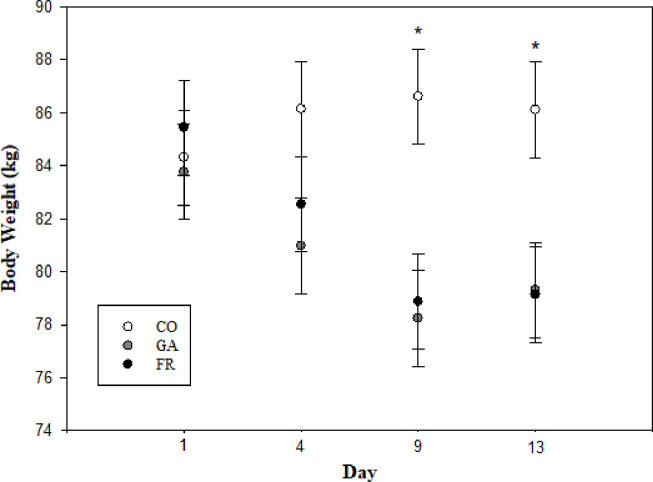
Body weight (BW, kg) during 13 days of treatment of synchronized ewes.Treatments were: (i) Control (CO): fed 1.5 times greater than the dietary maintenance and given a daily subcutaneous (SC) saline infusion (0.1mL/kg BW) (ii) Feed restriction (FR): ewes were fed a diet restricted to 80% of maintenance and given a daily SC saline infusion (0.1mL/kg BW); (iii) Ghrelin antagonist (GA): the same restricted diet as the FR and given a daily SC ghrelin antagonist infusion (7.5μg/Kg BW of [D-Lys3]-GHRP-6 diluted into 0.1ml/kg BW of saline solution). Time by treatment interaction P-value < 0.01. * indicate treatments differences (P ≤ 0.05) evaluated using the SLICE option in SAS.